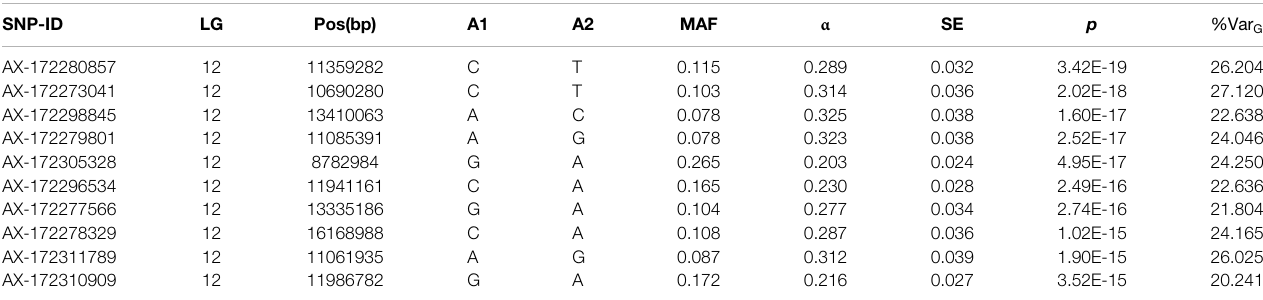
The SNPs are sorted based on their level of signi fi cance with LG, linkage group; Pos(bp), physical position of SNP; A1 & A2, Minor and major alleles, respectively; MAF, minor allele frequency; α ,allelesubstitutioneffectforA1allele;SE,standarderror; p ,signi fi cancevalue; %Var G ,proportionofthegeneticvarianceexplainedusingthedirectmethod.TheSNPpositions are based on genome build 1.0 (seabass_V1.0, Tine et al., 2014) of European sea bass.